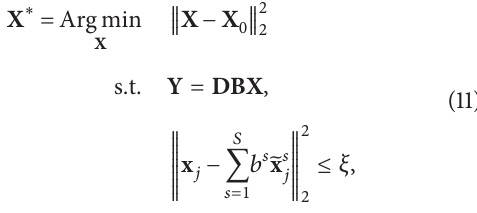
Algorithm 1 (the training phase of the wavelet domain super-resolution).